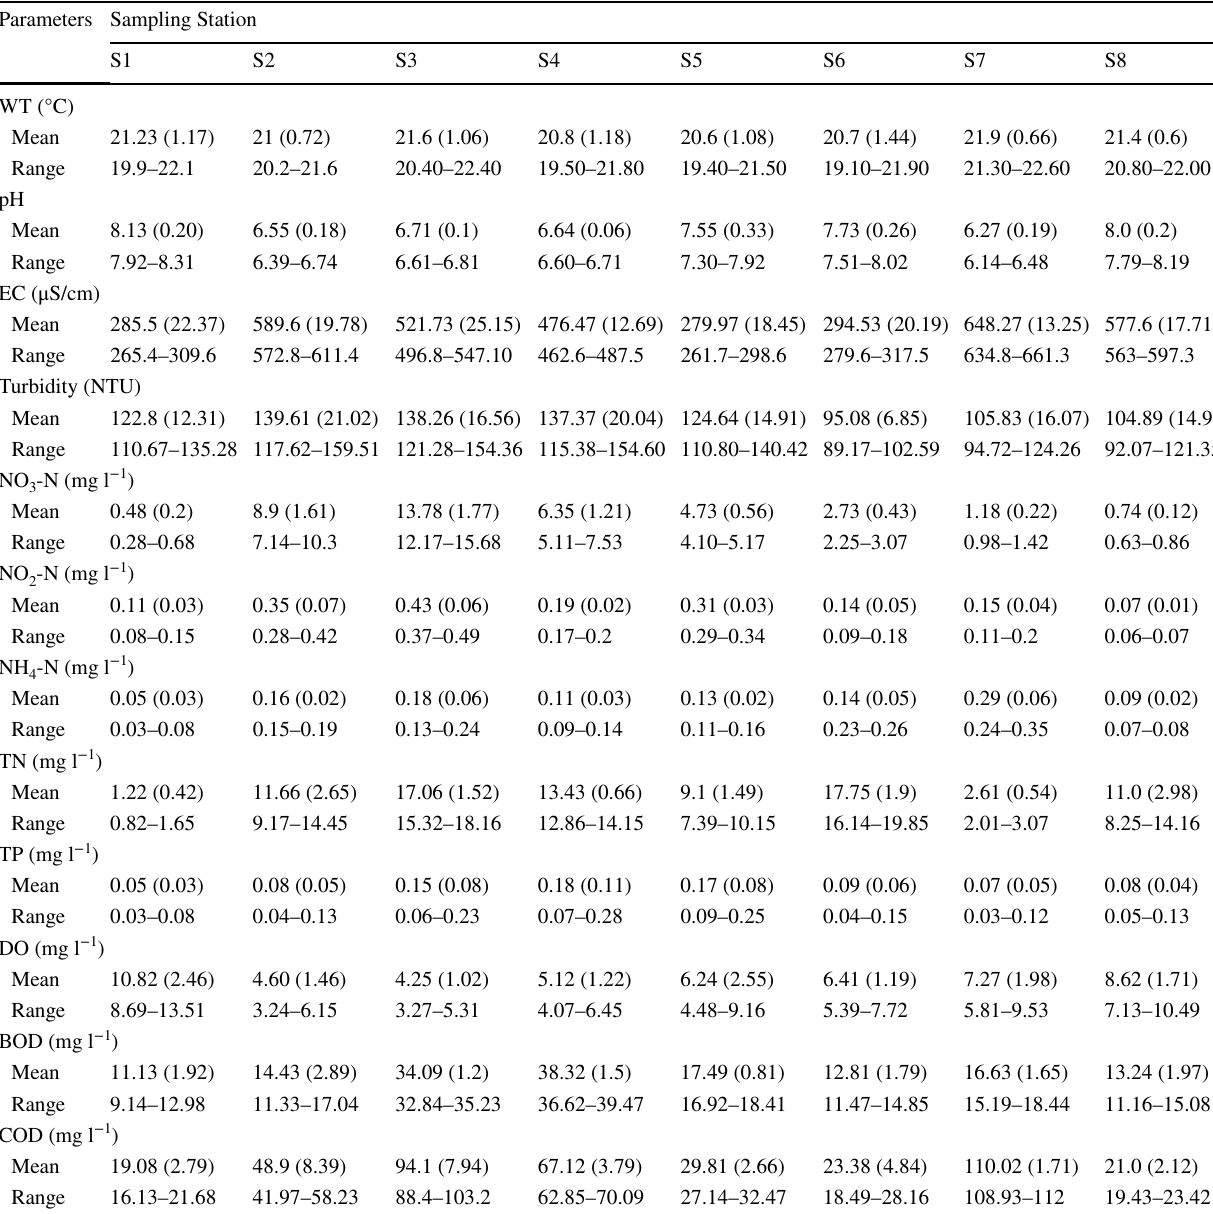
Table 2 Physicochemical water quality parameters at different locations of the Awash River during wet season